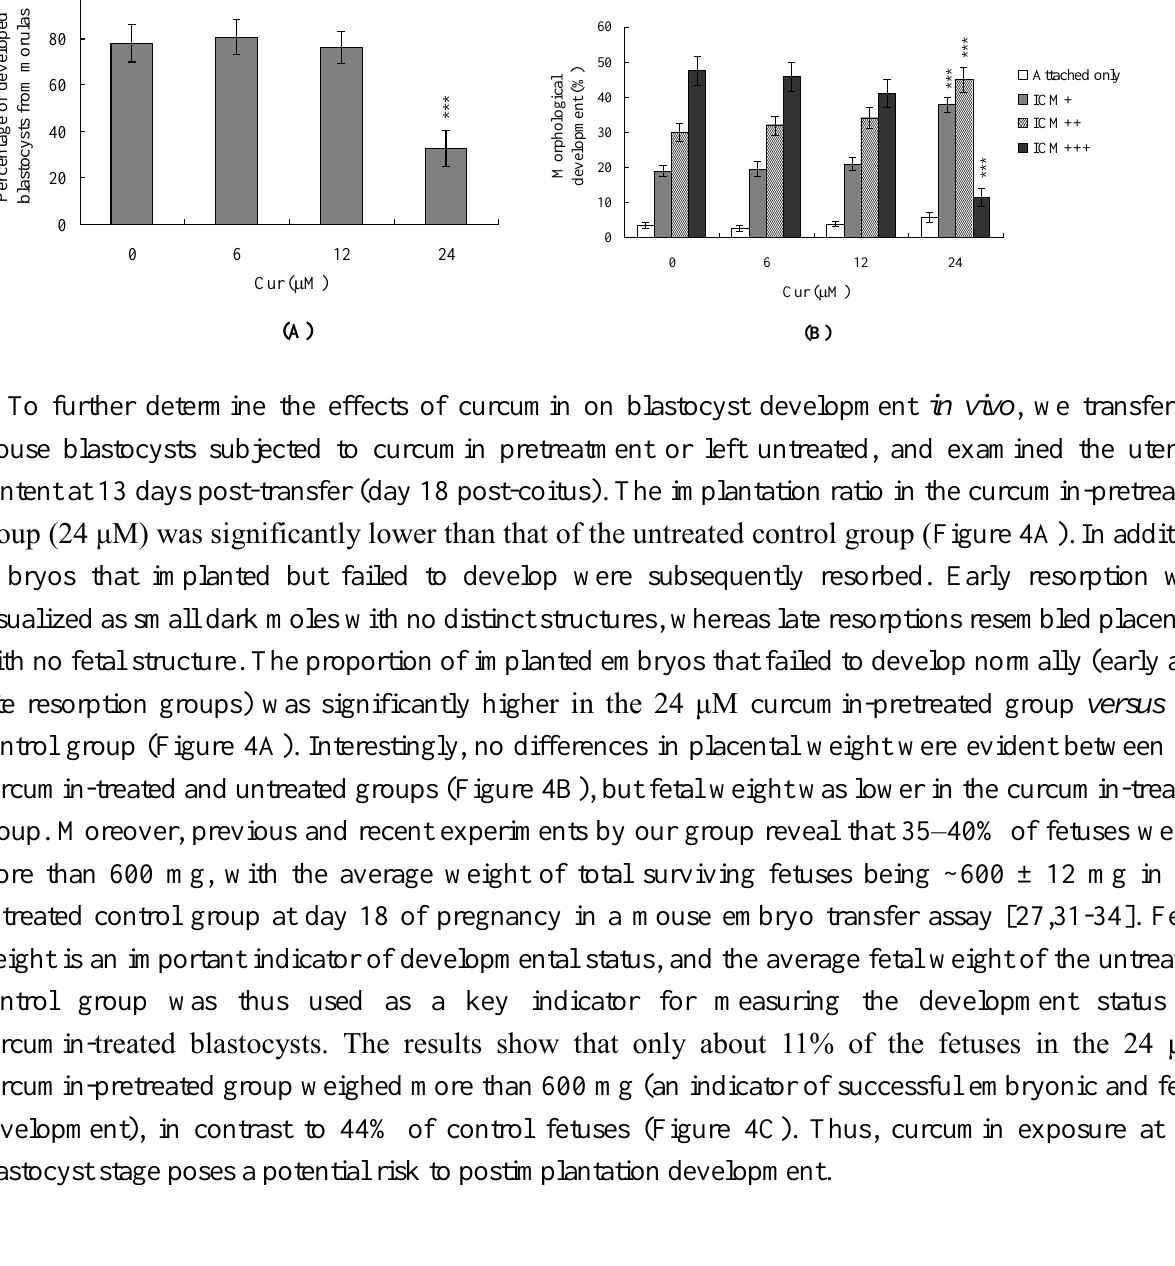
Figure 3. In vitro development of mouse embryos exposed to curcumin at the blastocyst stage. (A) Mouse morulas were treated with curcumin (Cur; 6, 12 or 24 μM) for 24 h or left untreated, and cultured for an additional 24 h at 37 °C. Blastocysts were counted and percentages calculated. (B) Mouse blastocysts were treated with curcumin (Cur, 6, 12 or 24 μM) for 24 h or left untreated, and observed in culture for 7 days post-treatment. Blastocysts were identified as attachment only, ICM (+), ICM (++), and ICM (+++) via morphological assessment, as described in Materials and Methods. Values are presented as means ± SEM of eight determinations. *** P < 0.001 versus the control